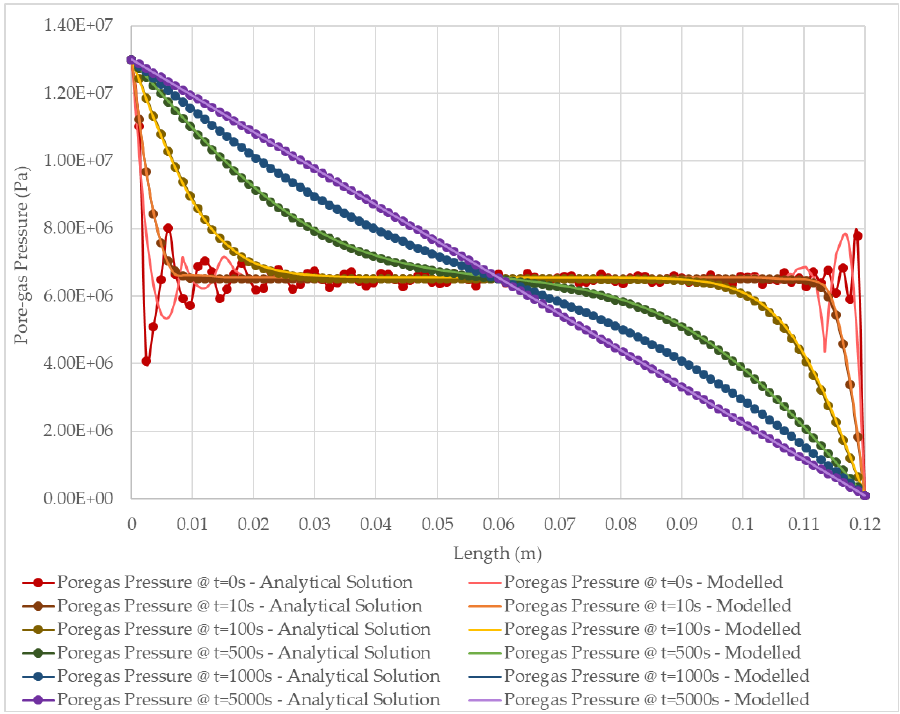
Figure 7. Verification study—1D transient solution results for poregas pressure and over the length of the specimen.